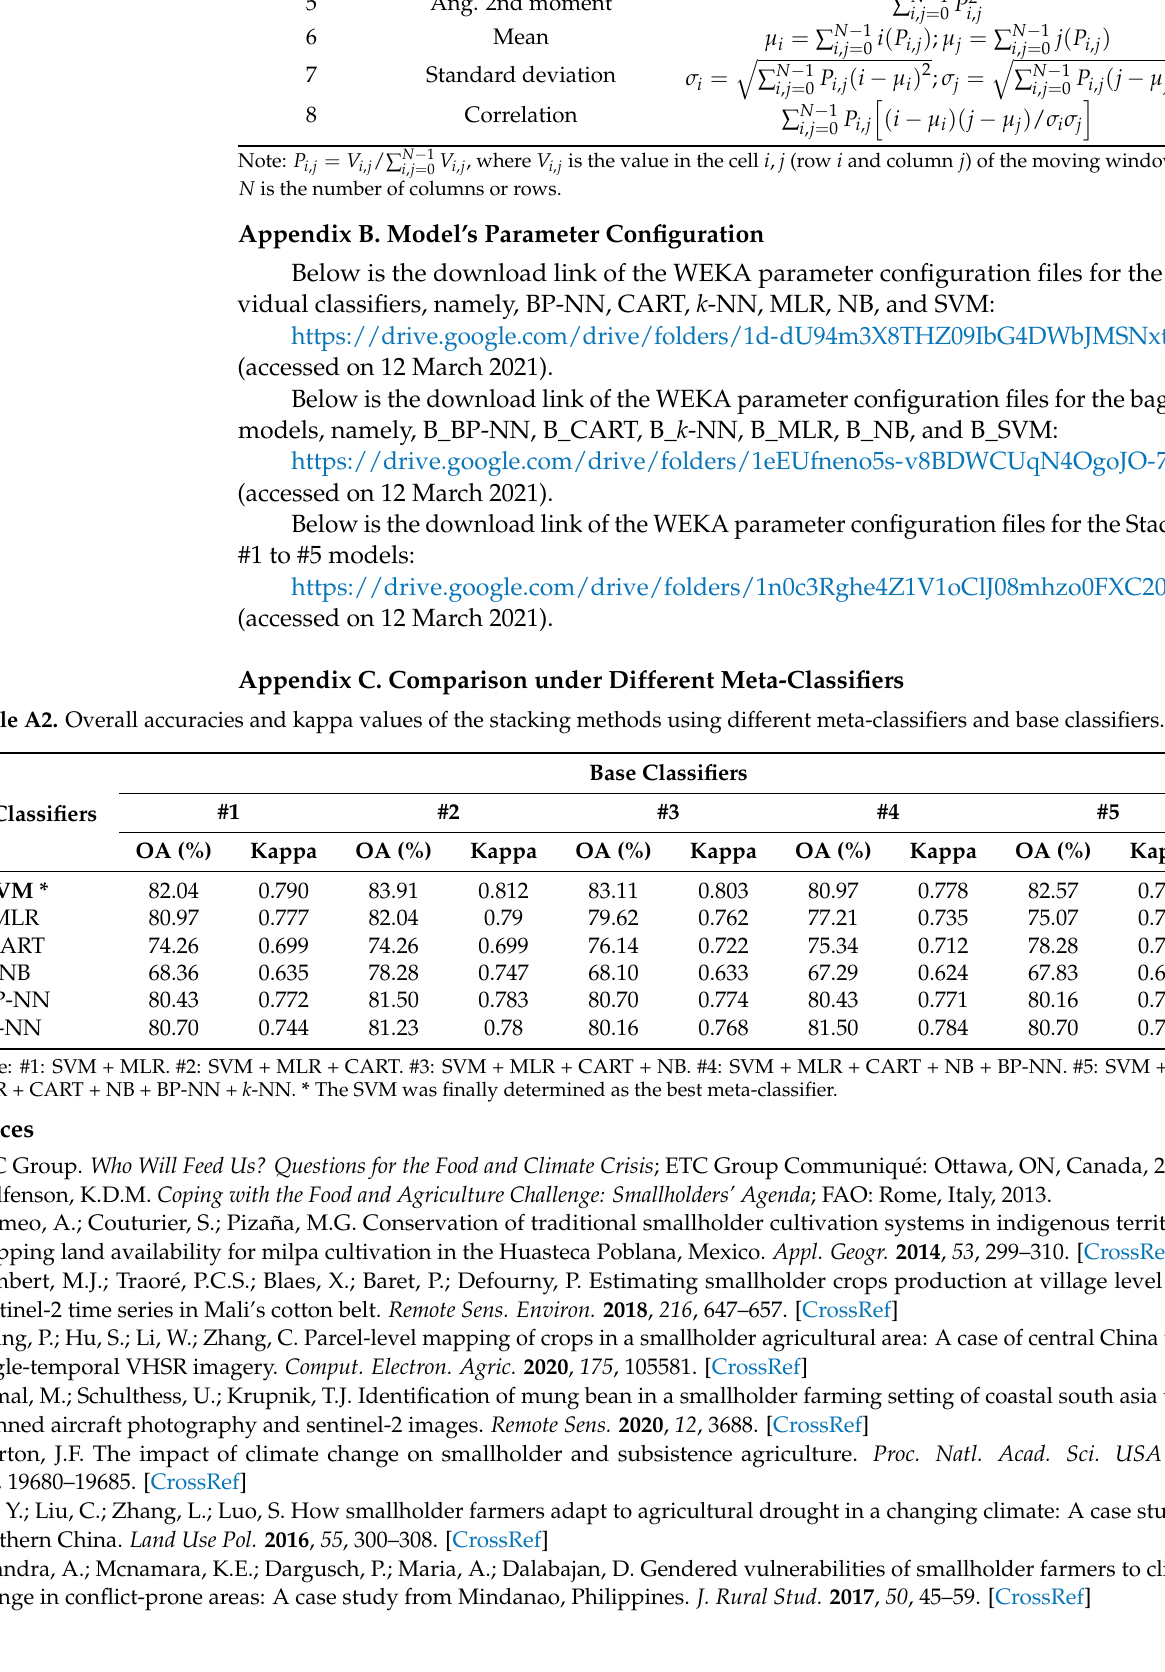
Table A1. Cont. No. Texture Measures